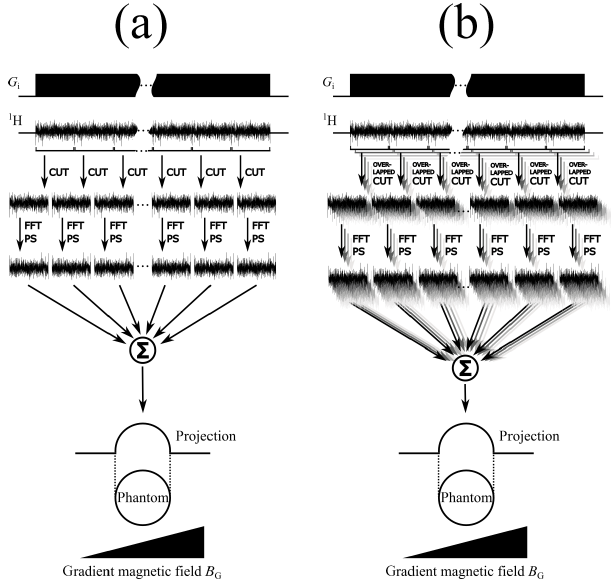
Figure 4. Comparison of sliding window processing schemes for spin noise data without (a) and with (b) overlapping windows. The acquisition sequence (including the frequency-encoding gradient magnetic field B G ) for recording one long noise block is shown on top. In the second step this block is cut up into multiple smaller noise blocks. After the fast Fourier transformation (FFT) and cal- culating the power spectra (PS), the sum of all individual spectra yields the final projection. In panel (b) the long noise block is cut up into overlapping sub-blocks, yielding a higher number of smaller noise